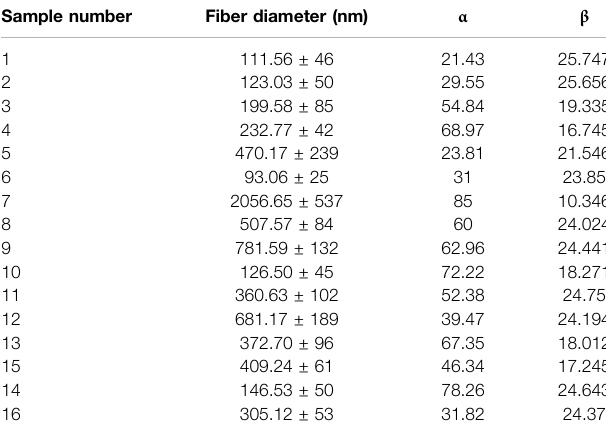
TABLE 2 | Values of fi ber diameter, α , and ß calculated for the scaffolds. Sample